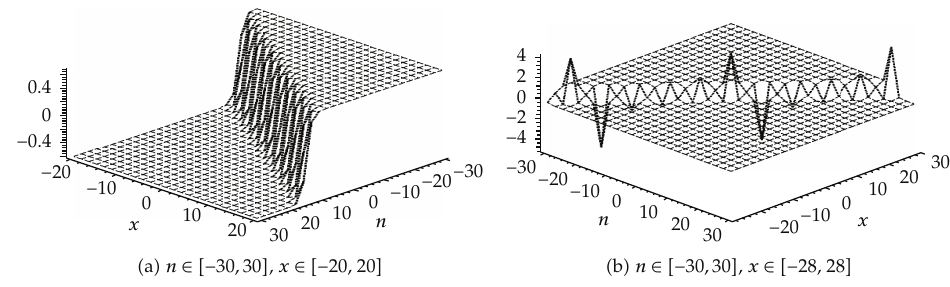
Figure 2: The solutions u n in (cid:2) 3.21 (cid:4) and (cid:2) 3.22 (cid:4) show two shapes of discrete antikink and kink solitons for fixed parametric values: a 0 (cid:8) 2, b 0 (cid:8) 3, a 2 (cid:8) − 1 . 5, b 2 (cid:8) 2 . 5, β (cid:8) 0 . 8, γ 0 (cid:8) 5, t (cid:8)